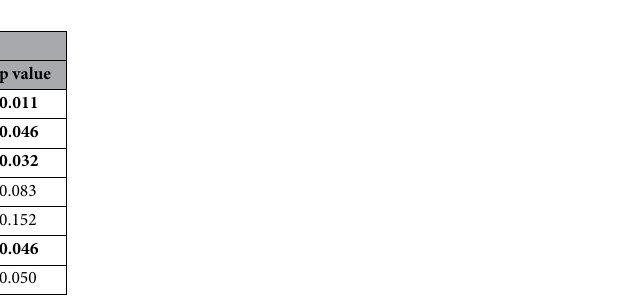
Table 4. Linear regression analysis in COVID-19 patients. a Among the 108 COVID-19 patients, 13 have been treated with steroids and/or azithromycin before hospitalization. Significant values are reported in